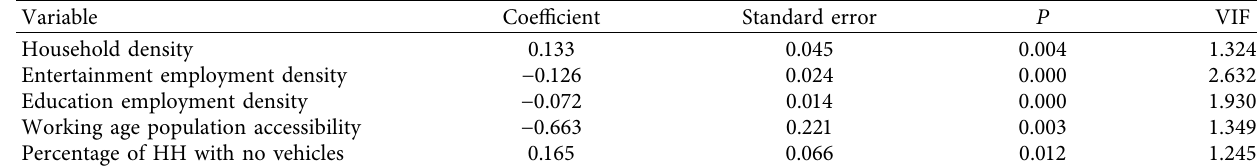
Table 4: MLR model results using the ratio of bike-sharing usage during/before COVID-19 as the response